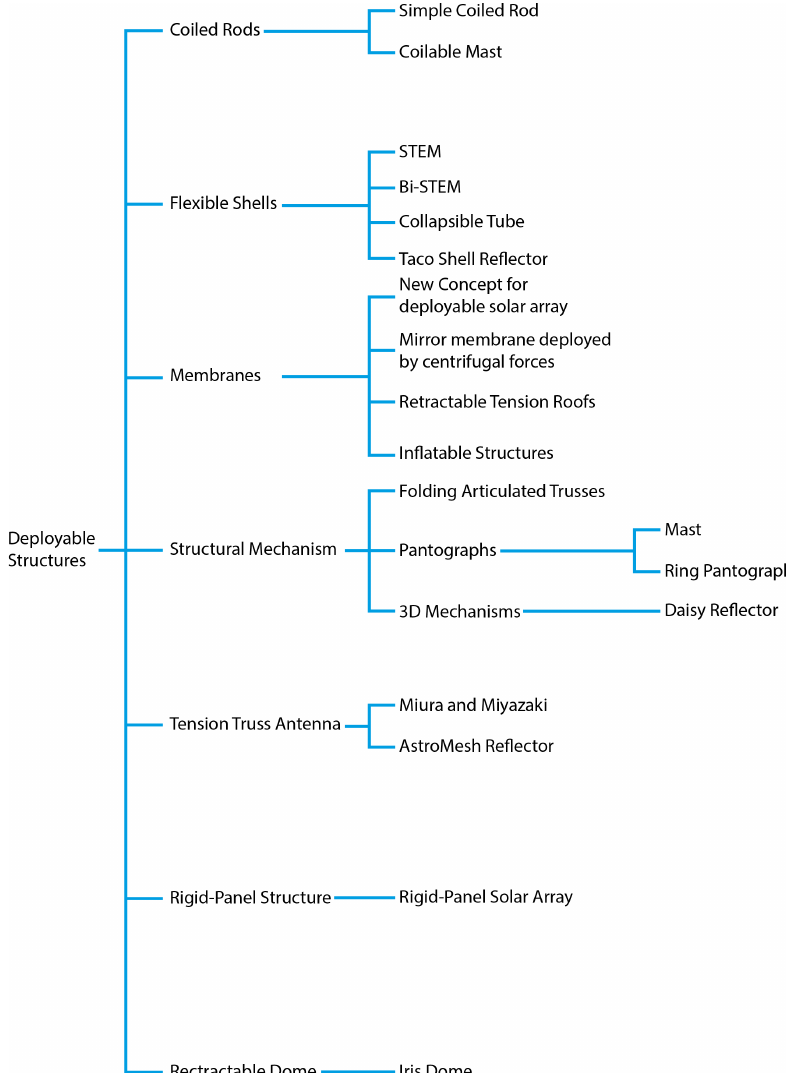
Figure 6: Pelegrino’s classification of deployable structures from 2001